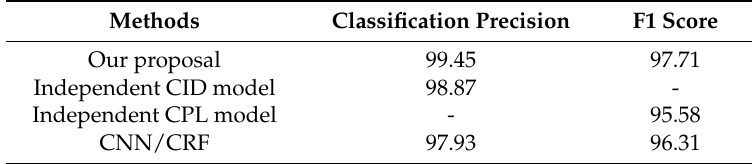
Table 6. Experimental results of CIU model. CNN: convolutional neural networks; CID: controlling-intent detection; CPL: controlling parameter labelling; CRF: conditional random